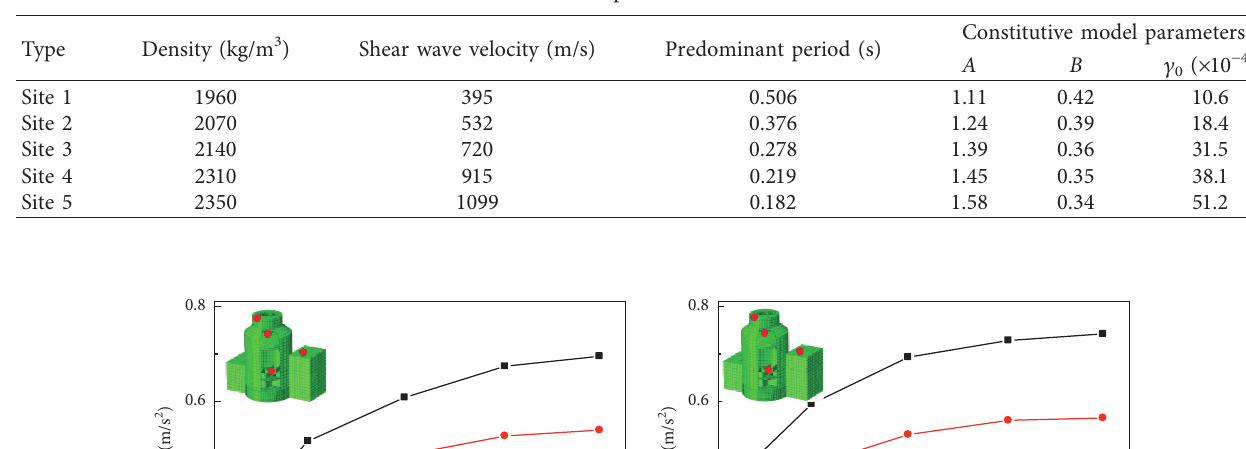
Table 6: Basic mechanical parameters for different SR sites.